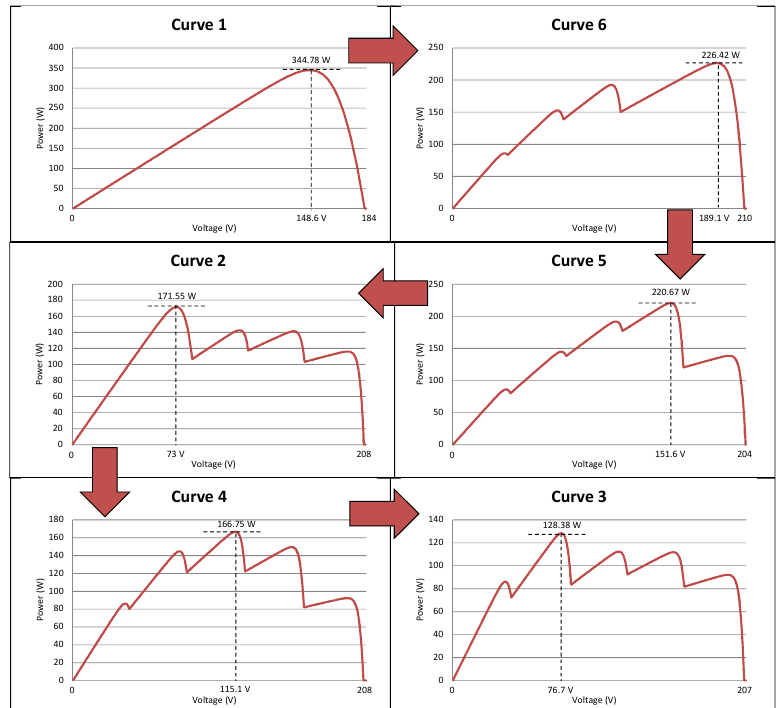
Table 6. Tracking efficiency of dynamic case.